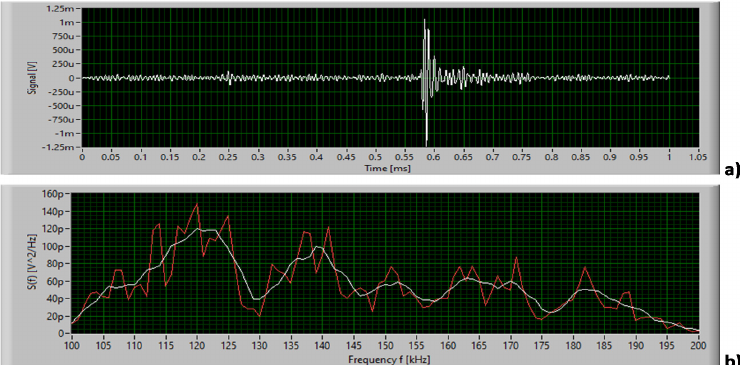
Figure 6. ( a ) The transient signal; ( b ) Fourier transform of a fragment of the AE signal registered with a WDI type wideband sensor, signal duration ∆ t = 30 μ s.